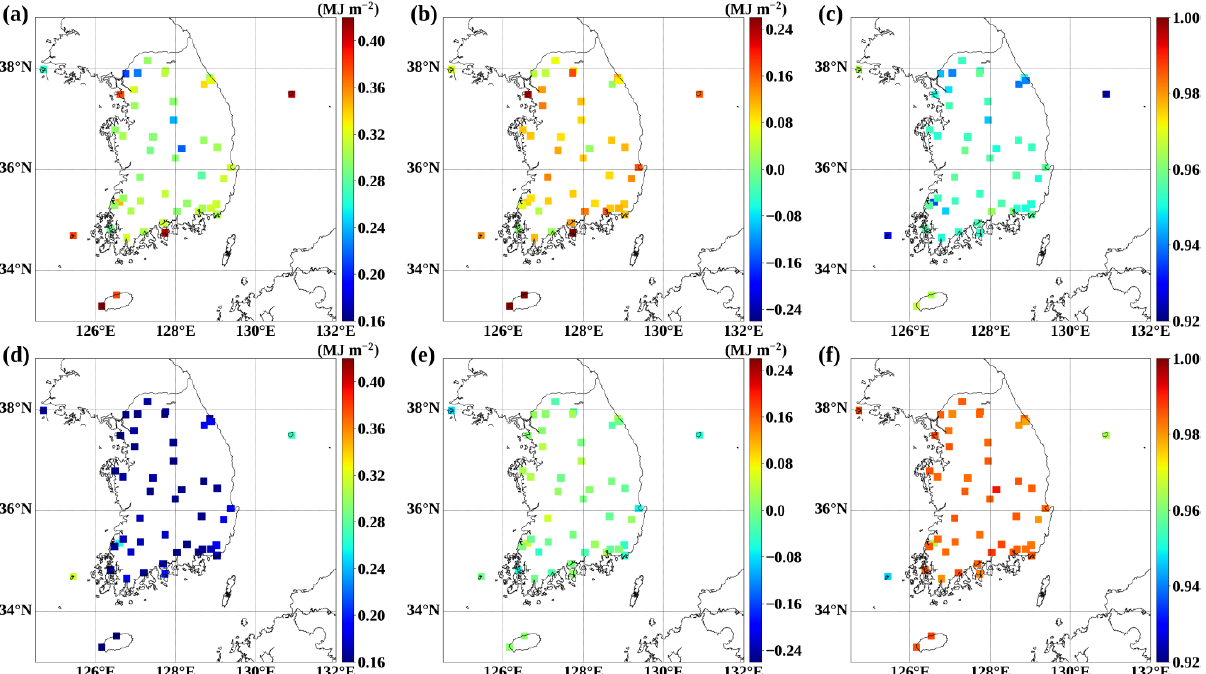
Figure 7. Comparison of the estimated SSI from GK2A/AMI using ( a – c ) the operational algorithm and ( d – f ) CNN, and in situ SSI measurements from KMA ASOS stations, for the period from 1 August 2020 to 31 January 2022, where the colored squares represent ( a , d ) RMSE, ( b , e ) bias, and ( c , f ) Pearson’s R .